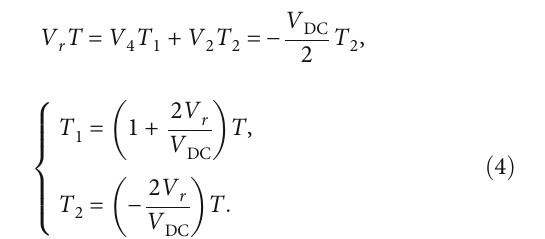
Section B: when the inverter reference voltage, V r , is between 0.5 V and zero or V and V , respectively, the DC 4 5 switching times are divided between these two e ff ective vectors according to Equation (3), where T and T are the duty cycles 1 2 of the zero voltage vector and 0.5 V level, respectively. DC Section C: when the inverter reference vector, V r is between -0.5 V and zero voltage vector or V and V , DC 4 2 respectively. According to Equation (4), T and T are duty 1 2 cycles of zero voltage vector and -0.5 V level, DC respectively.